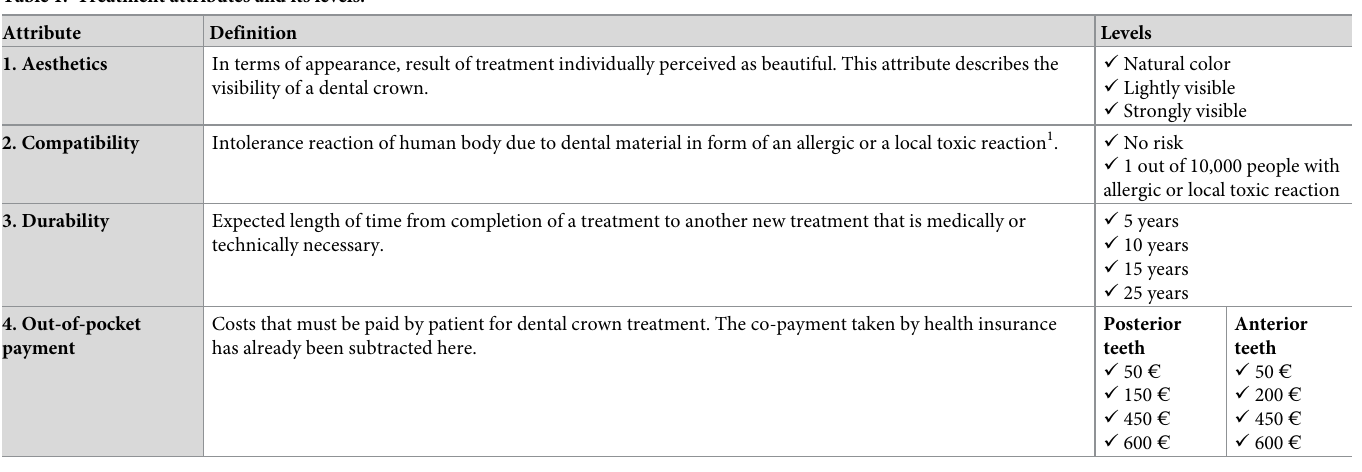
Table 1. Treatment attributes and its